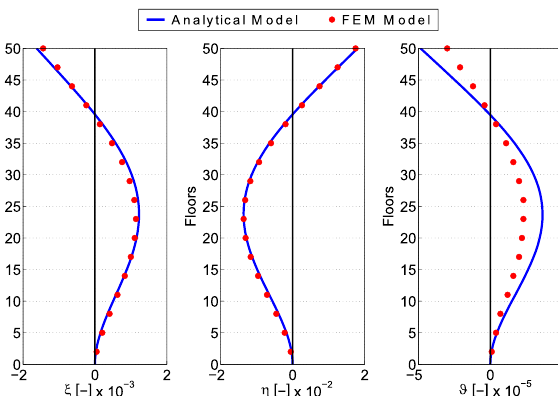
Figure 8: Normalized eigenvector components of the 5th mode shape